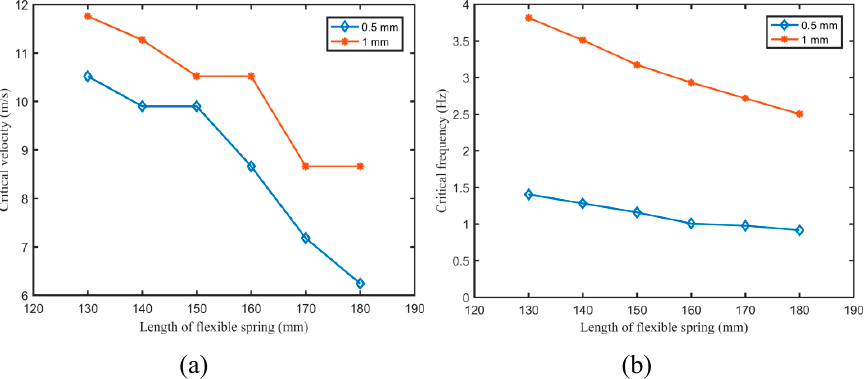
Figure 5. Variations of the critical velocity ( a ) and the critical frequency ( b ) of the harvester with the length of the flexible spring at thicknesses of 0.5 and 1 mm.